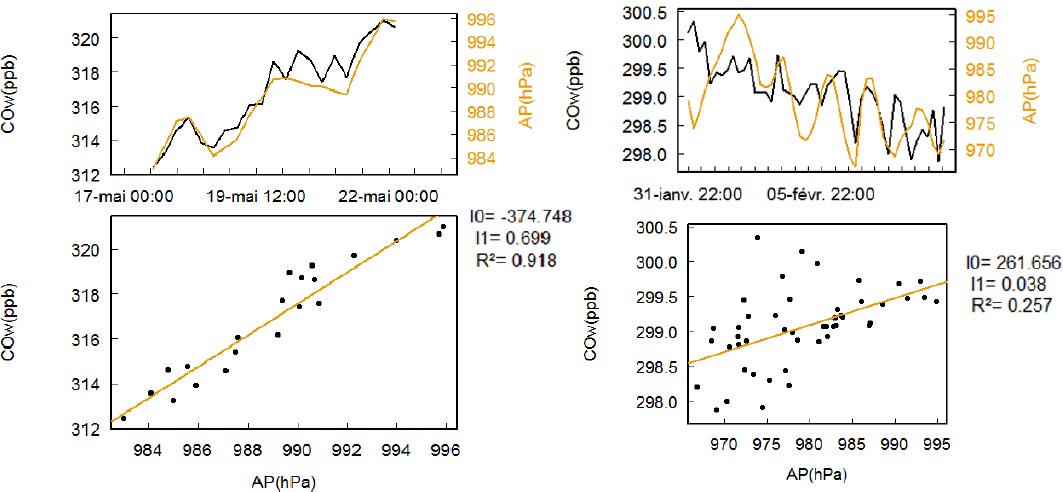
Figure 8. CO pressure dependence before (left) and after (right) repair at the factory for CFKADS2084. Among the tested instruments, four others were showing a dependence higher than 4ppbhPa − 1